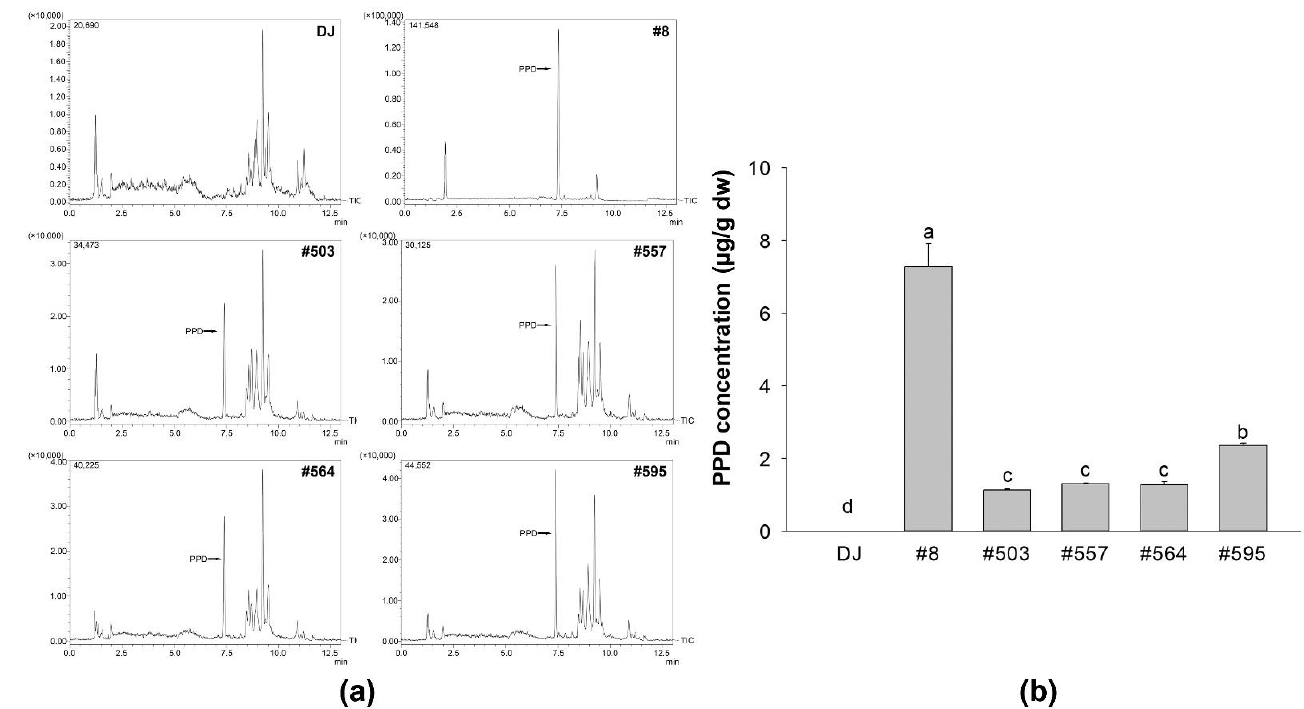
Figure 9. PPD production in the transgenic rice seed extracts. ( a ) Representation of the MS chromatograms of PPD detected in transgenic rice seed extracts (the Y axis of sample #8 is ×100,000, whereas the Y axes of the other samples are ×10,000). ( b ) The amount of PPD in each transgenic rice line. Data are presented as means ± standard deviations. Lowercase letters (a, b, c, and d) indicate significant differences at p < 0.05 among the treatments.